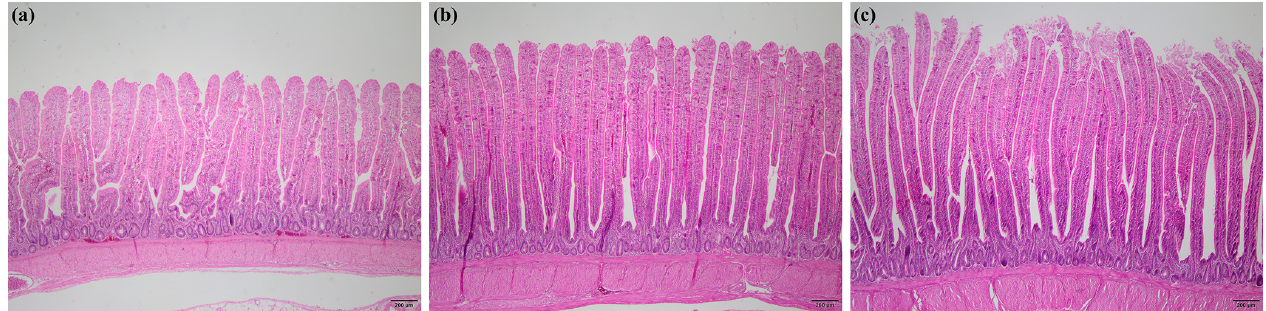
Figure 1. Representative photomicrographs of jejunal histomorphology of broiler chickens in (a) control, (b) phytogenic feed additive, and (c) phytogenic feed additive + Bacillus licheniformis groups.